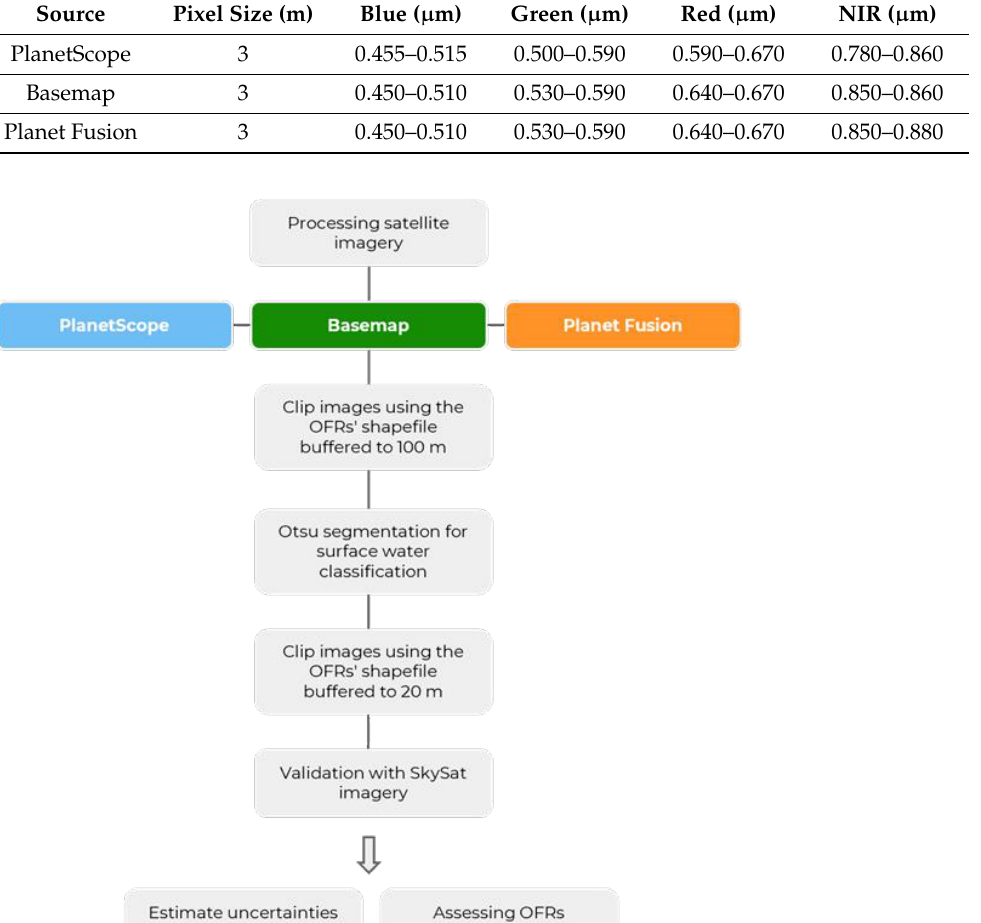
Table 1. PlanetScope, Basemap, and Planet Fusion image spatial resolutions and different wave- lengths bands.